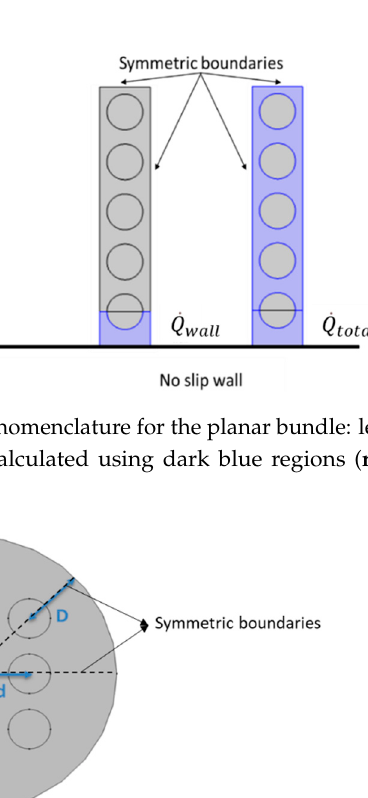
Figure 6. Solution domain nomenclature for the circular bundle and symmetric boundaries.